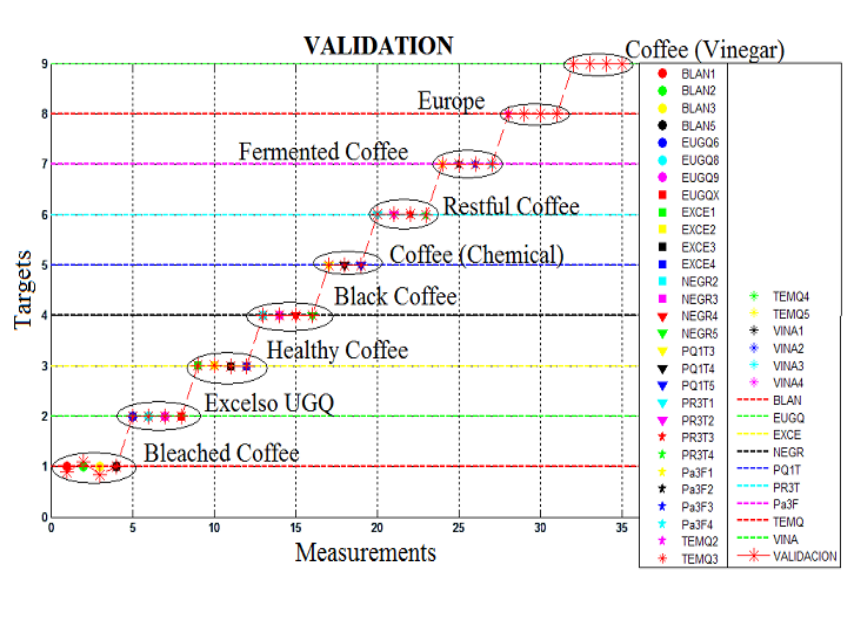
Figure 10. Validation of the measures in the second analysis with the neural